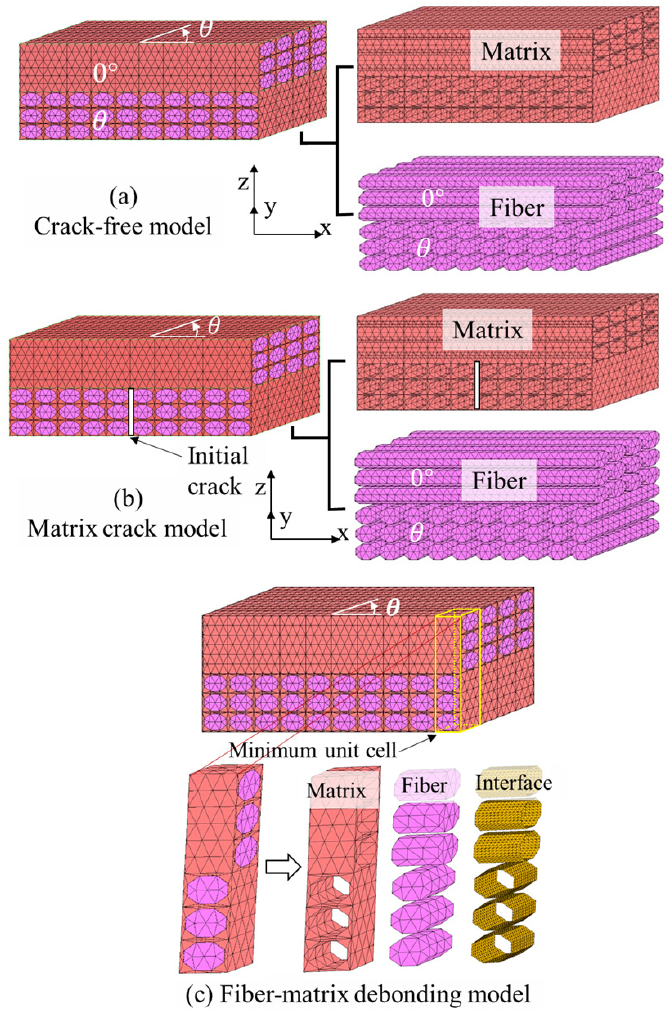
Figure 10. Three analysis models: ( a ) Crack-free model; ( b ) Matrix crack model with interface elements or initial crack inside; ( c ) Fiber-matrix debonding model.